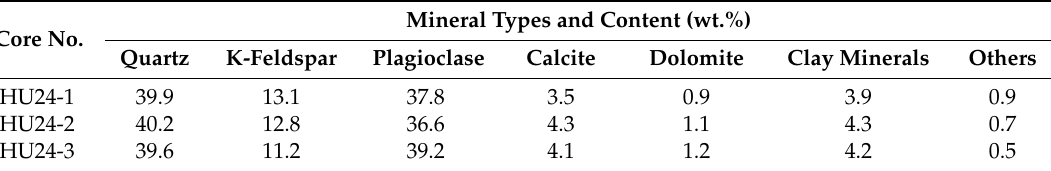
Table 4. Types and contents of mineral in the core samples.